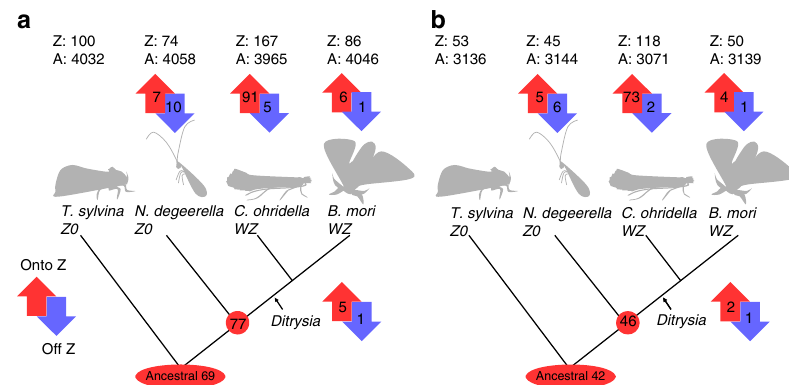
Fig. 4 Gene movement onto and off the Z chromosome. a Lenient classi fi cation (4132 genes classi fi ed). b Stringent classi fi cation (3189 genes classi fi ed). The phylogenetic tree is adapted from Regier et al. 51 . Red circles show the number of genes present on the ancestral Z chromosome. Arrows indicate the number of genes that move onto (up red arrows) or off (down blue arrows) the Z chromosome in each lineage after the split with T. sylvina . The top row indicates the total number of genes classi fi ed as Z-linked (Z) or autosomal (A) in